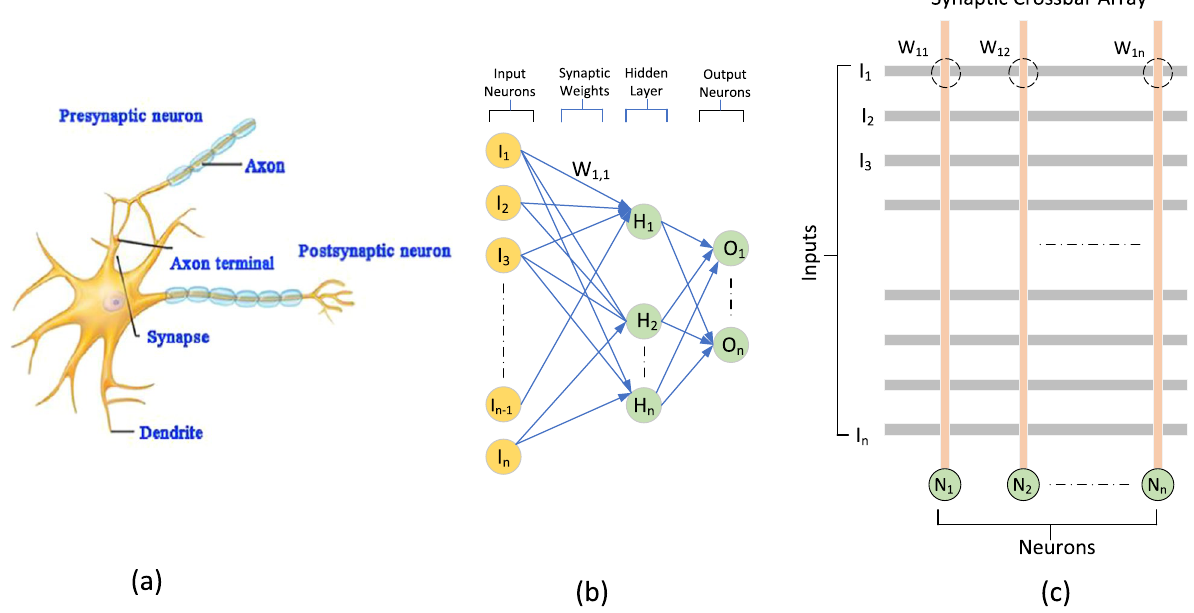
Fig. 26 a Biological neural network. b Artificial neural network. c Hardware implementation of artificial neural network using crossbar